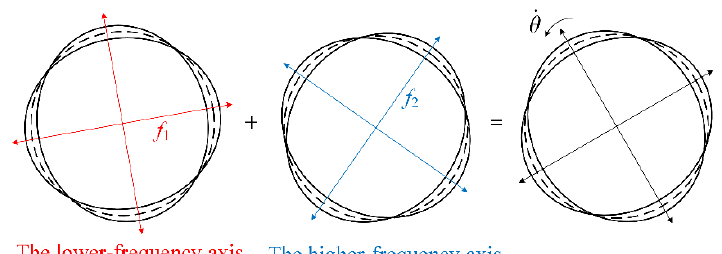
Figure 2. Principle of n = 2 standing wave precession induced by unbalanced mass. The superposition of two basic modes ( f 1 < f 2 ) near the ideal second mode f 02 causes the standing wave precession at a specific angular rate. This rate is proportional to the frequency split ∆ f = | f 2 – f 1 |.